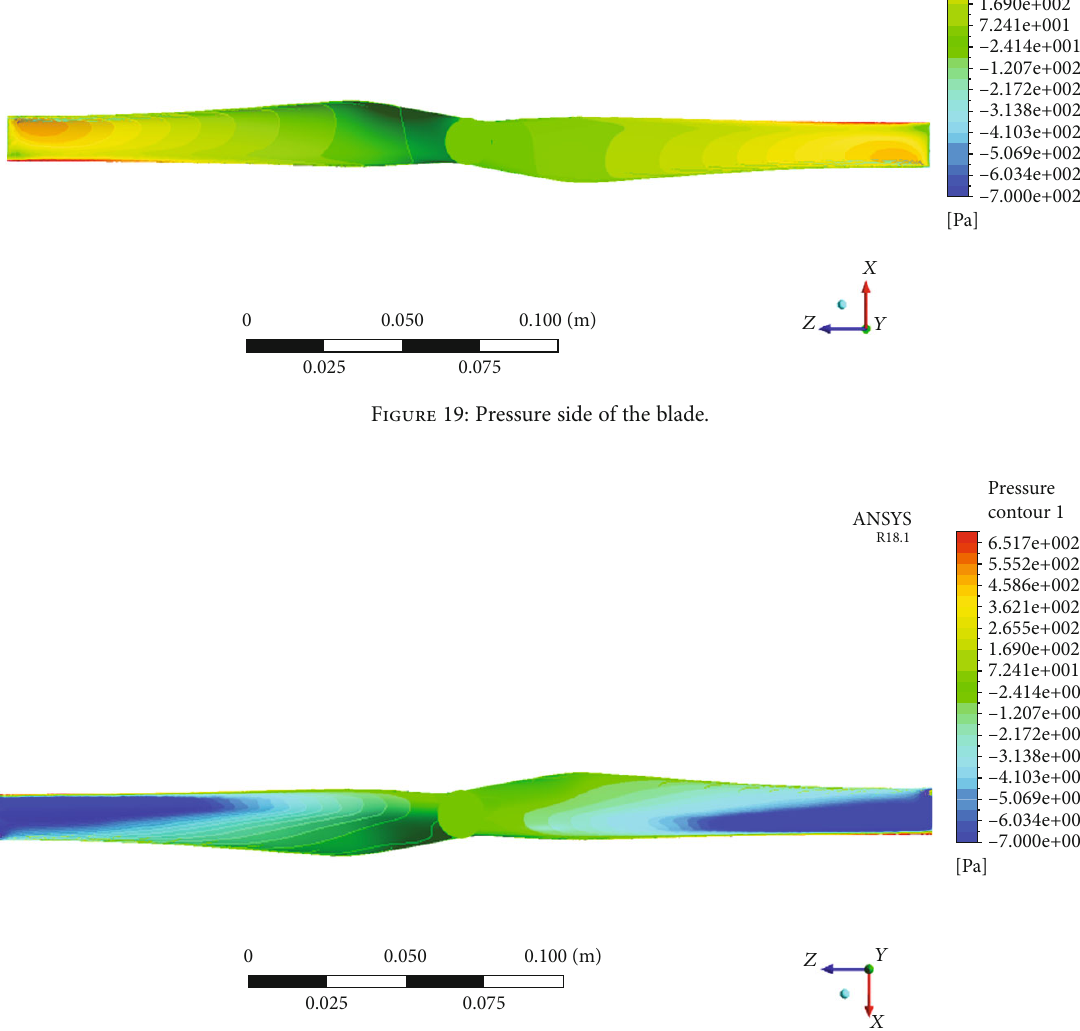
Figure 20: Suction side of the